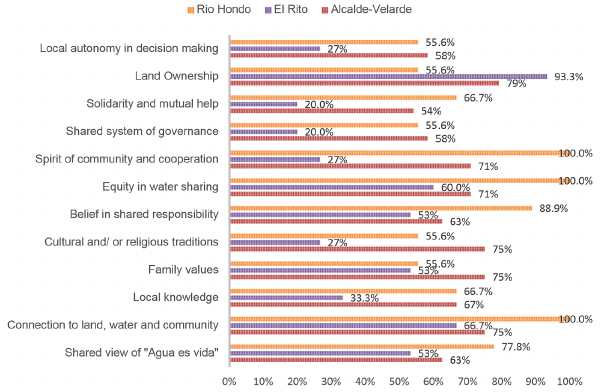
Figure 10. Acequia characteristics perceived to “best contribute” to acequia adaptive capacity, past adaption, and